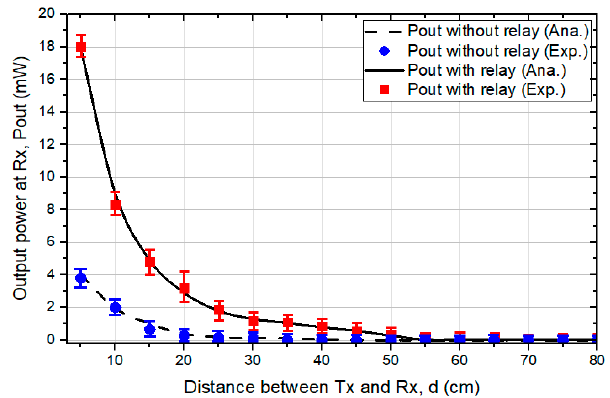
Figure 5. Comparison of simulated and experimental harvested power between typical wireless power transfer (WPT) and wireless power transfer using a relay resonator (WPT-R) systems.